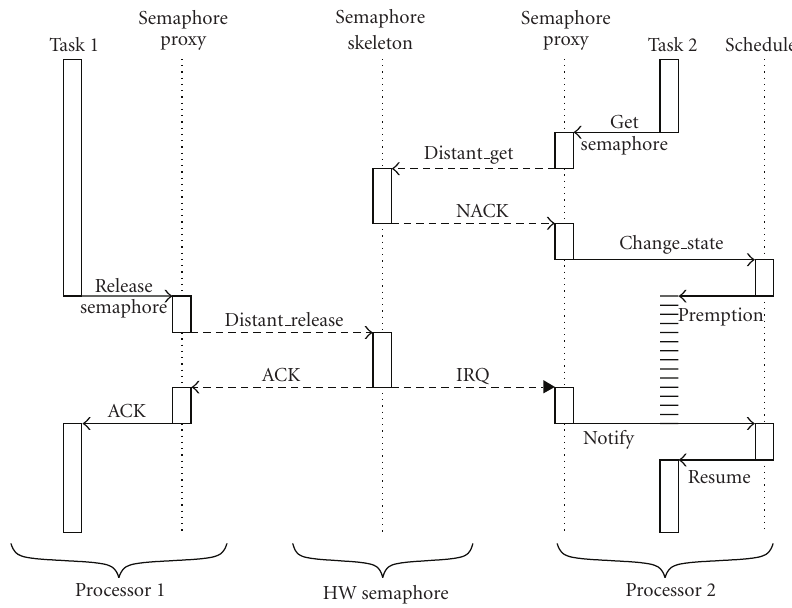
Figure 7: Activity diagram of local/distant calls to a shared semaphore proxy/skeleton between two OS